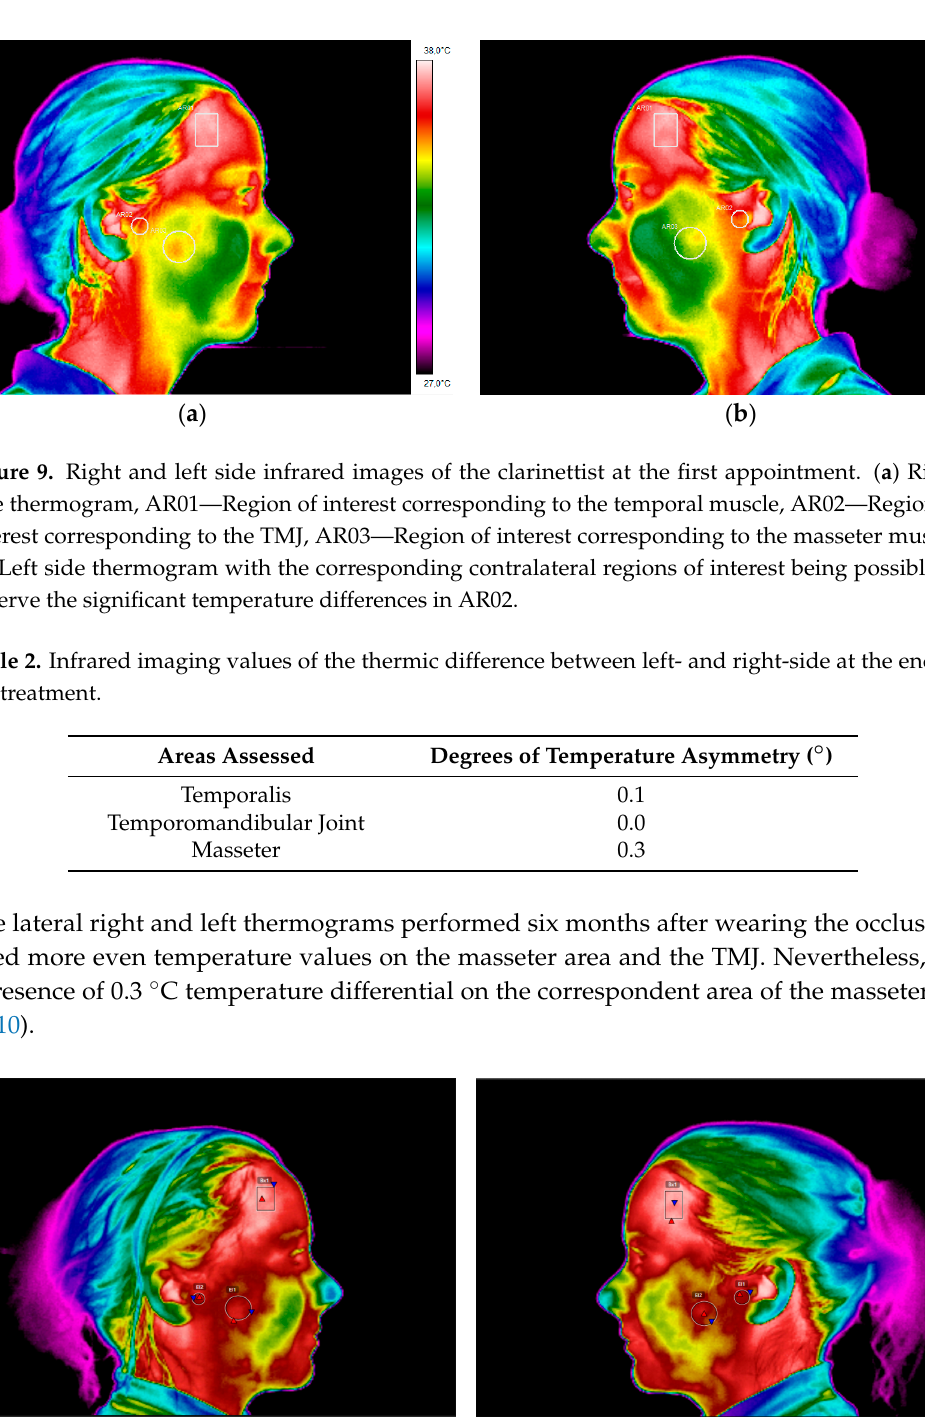
( b ) Figure 8. ( a ) Verifying the adaptation of the piezoresistive sensors on the musician’s mouthpiece; ( b ) Clarinet player performing different pitches whilst recording the pressure applied at the upper central incisors . 3. Results The clinical outcomes resulting from this work where the RDC/TMD diagnoses indicated that the clarinet player had an internal derangement on both TMJ, with an osteoarthritis on the left TMJ and an anterior disc displacement with reduction on the right TMJ. Concerning the muscular analyses, the results enabled the authors to check the presence of myofascial pain. In fact, these clinical observations are in agreement with the infrared thermograms that were analysed, since it was possible to compare the existing temperature differential of the areas assessed, namely the anterior temporal muscle with 0.1 °C, the TMJ with 0.1 °C and the masseter muscle with 0.7 °C (Table 1). These values correspond to the initial thermograms that were taken at the first appointment prior to the treatment with the stabilisation appliance. Table 1. Infrared imaging values of the thermic difference between left ‐ and right ‐ side at the first appointment. Areas Assessed Degrees of Temperature Asymmetry (°) Temporalis